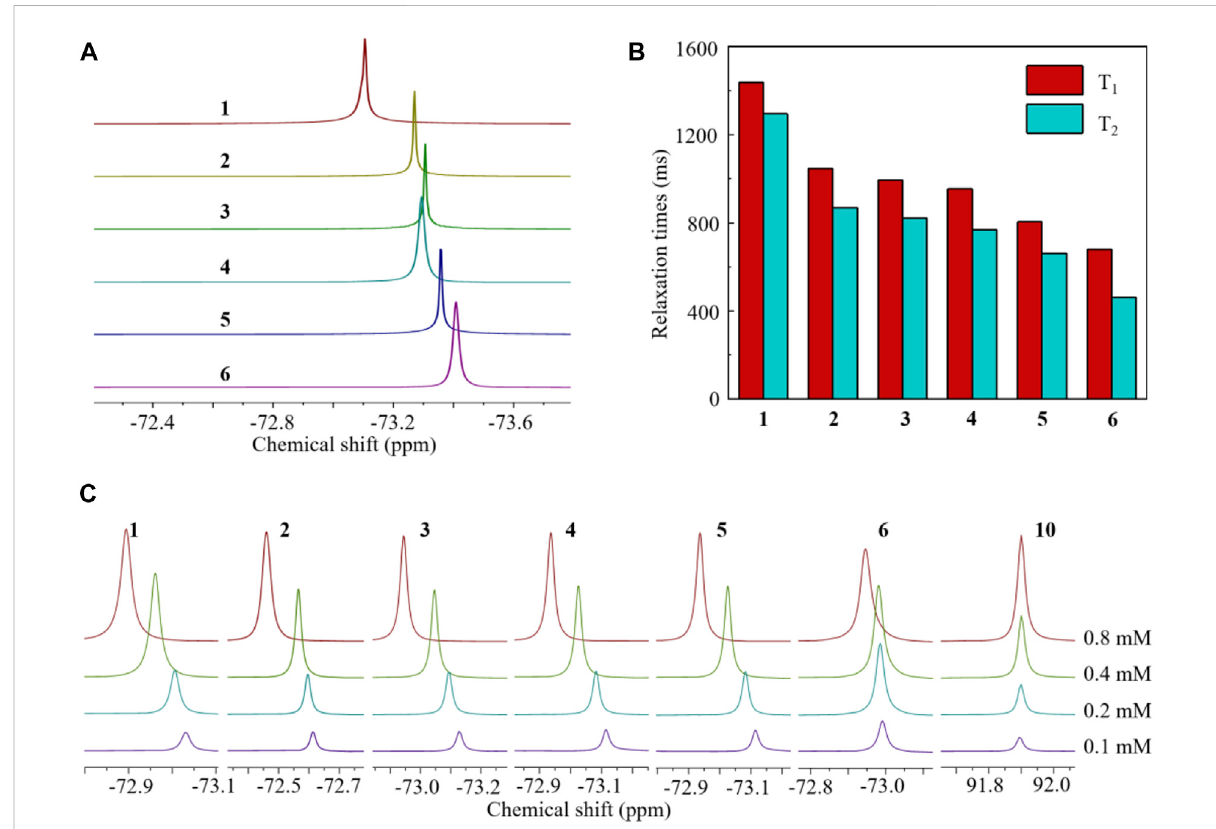
FIGURE 2 Partial 19 F NMR spectra [ (A) , in CDCl 3 ], 19 F relaxation times [ (B) , 0.4 mM in PFMCH], and concentration-dependent 19 F NMR spectra [ (C) , in PFMCH, with per fl uoro-20-crown-5 10 as a control] of HFCs 1 – 6. All 19 F NMR experiments were performed at 500 MHz at room temperature. Hexa fl uorobene was used as the internal